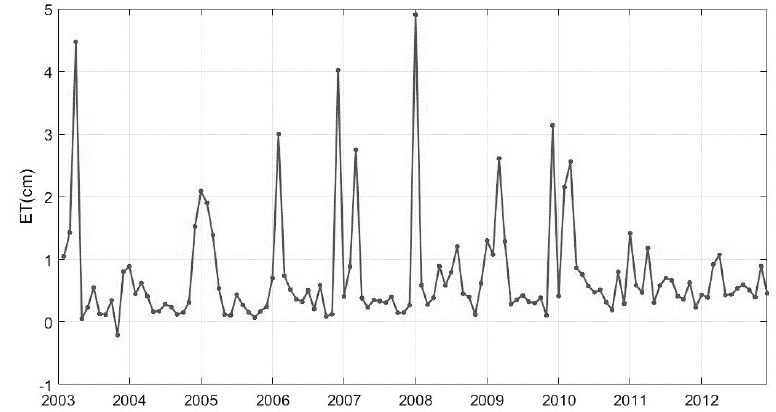
Figure 17. Evapotranspiration time series obtained from the water budget equation from 2003 to 2012.